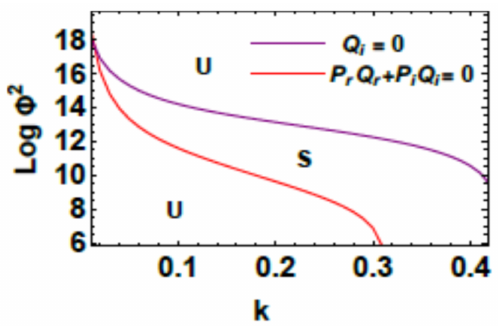
Figure 14. Variation of Log Φ 2 with k to depict the contribution of Equations (53) and (54) along with data